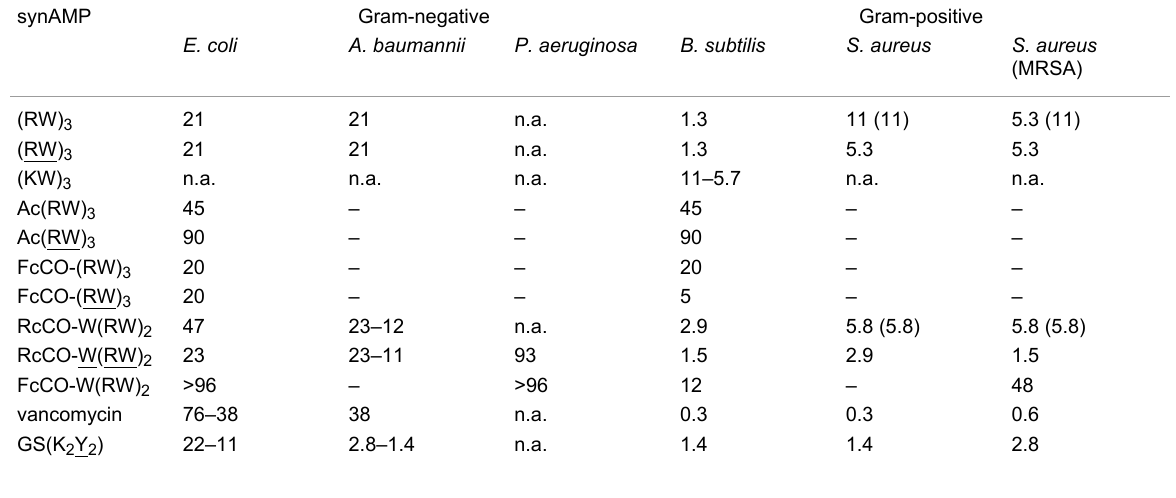
Table 2: Minimum inhibitory concentrations (µM) in the cell culture medium of the synAMPs described in this study (according to CSLI guidelines). Peptides have C-terminal carboxamides and are not derivatized on the N-terminus except where noted, i.e., with acetyl (Ac), FcCO or RcCO. Values in brackets are determined in Mueller–Hinton (MH) medium. More details on the bacterial strains can be found in the experimental section.